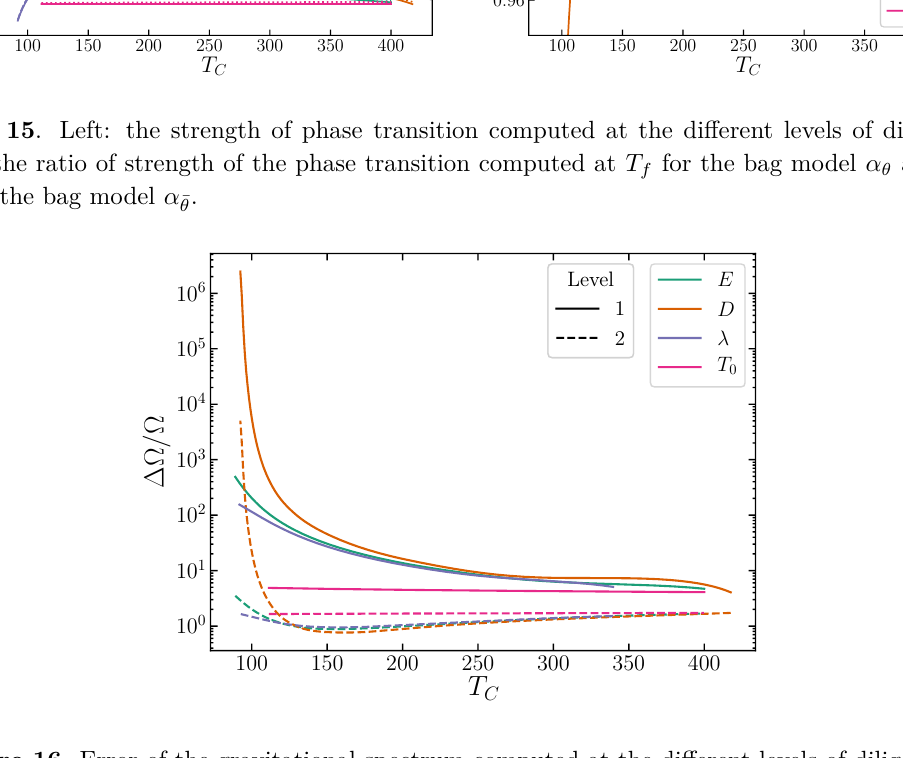
Figure 16 . Error of the gravitational spectrum computed at the different levels of diligence.